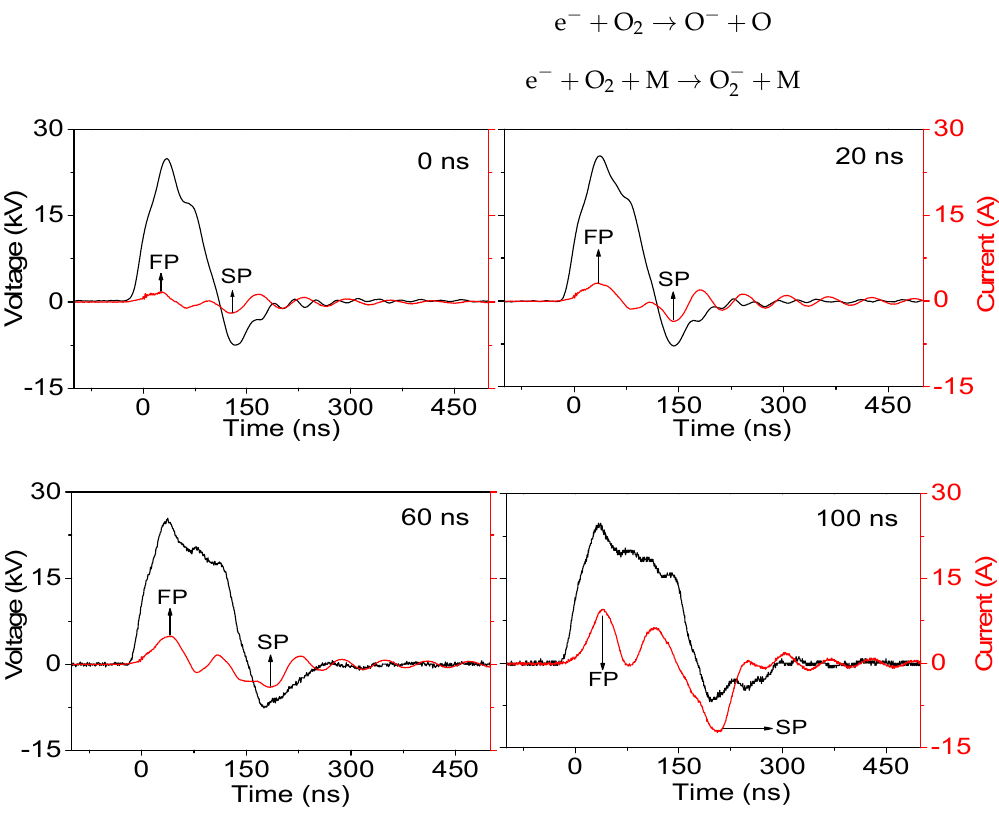
Figure 2. Waveforms of the applied voltages and discharge currents under different pulse durations in air.